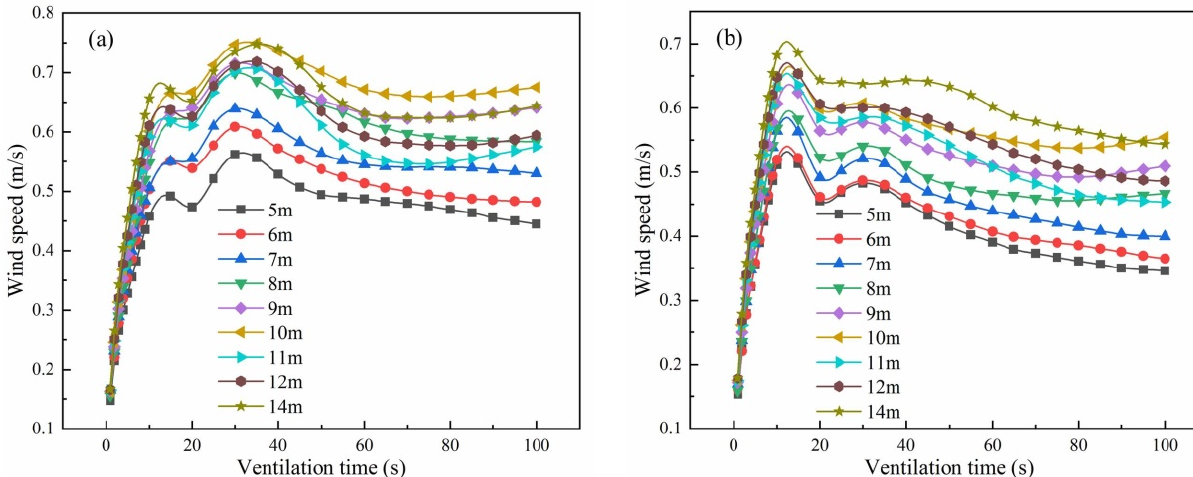
Figure 15. Air velocity variation of the clustered solar greenhouse under different building spacings: